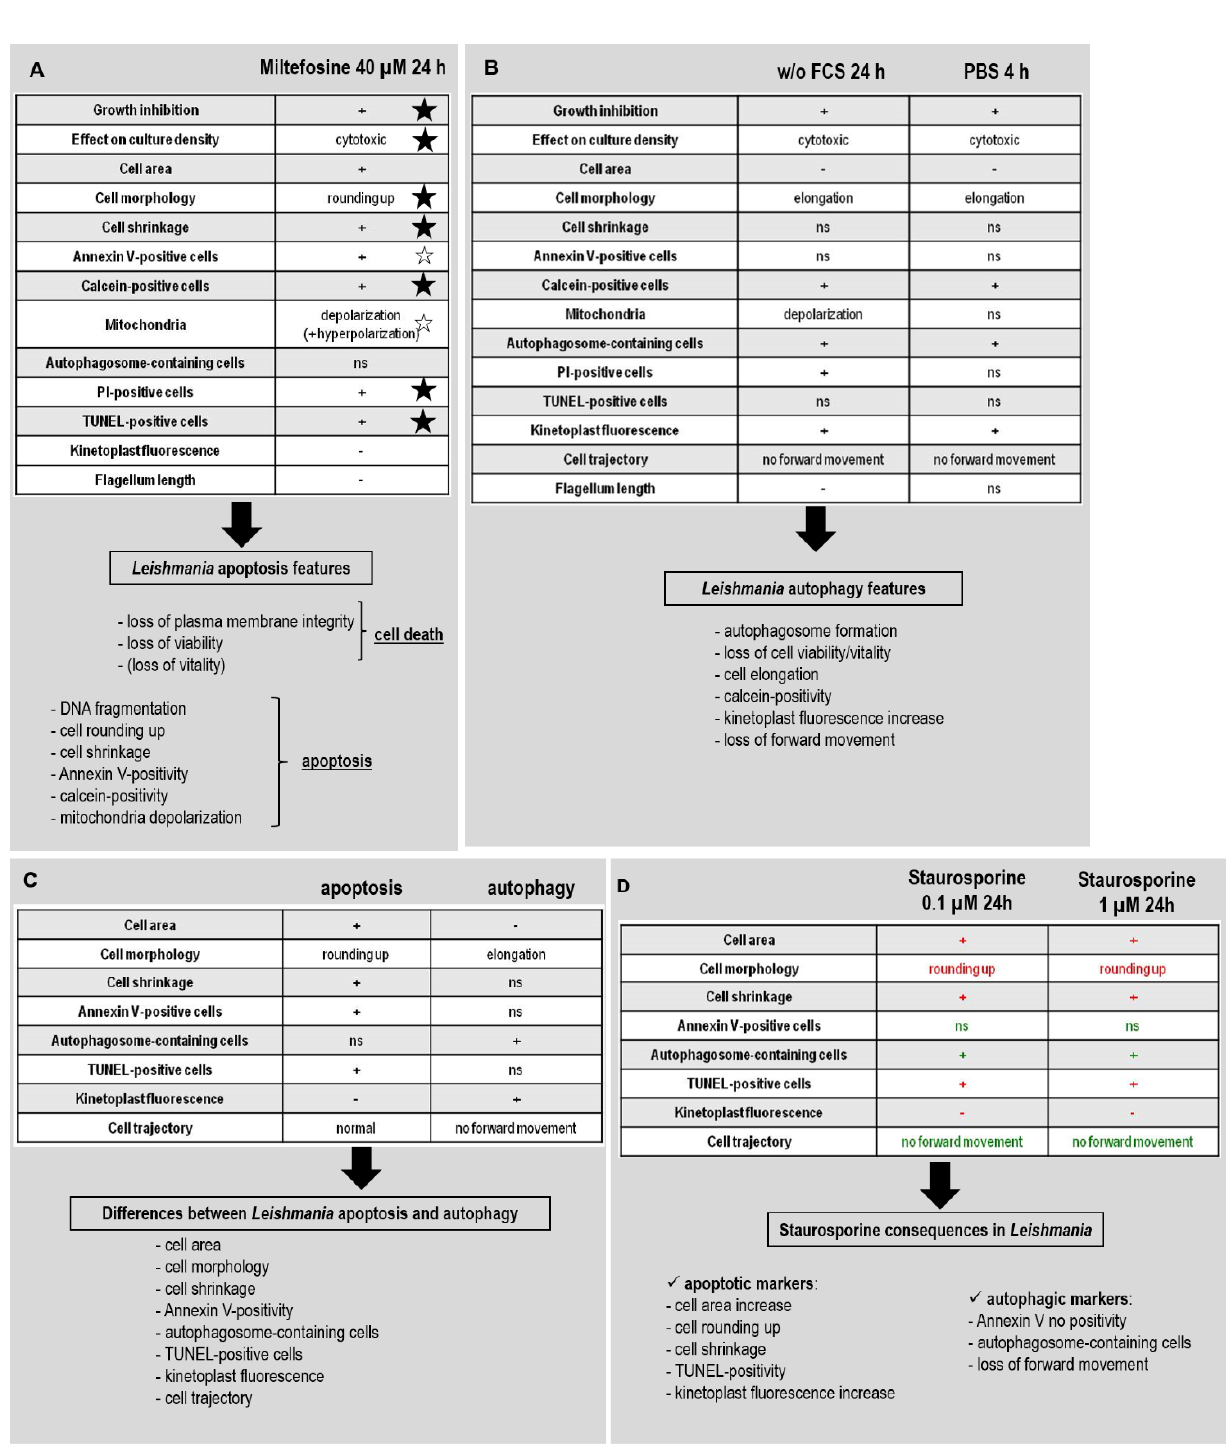
FIGURE 7: Proposed procedure to identify Leishmania apoptotic cells, autophagic cells and to clearly distinguish apoptosis and autophagy. (A) Leishmania miltefosine-induced apoptosis markers. A star indicates the apoptotic markers that have been found not only in miltefosine- induced apoptosis but also after induction of apoptosis by other molecules: a solid star when demonstrated in this article and an empty star when shown in the literature (see discussion for details). The proposed approach to demonstrate Leishmania apoptosis is also summarized. (B) Leishmania autophagy markers. The list of features observed in deprivation conditions (without FCS for 24 h and in PBS for 4 h) as well as the proposed approach to demonstrate Leishmania autophagy are summarized. (C) Features to distinguish apoptosis and autophagy in Leish- mania . The characteristics that are different during Leishmania apoptosis and autophagy and so that allow distinguishing the two processes are enumerated. (D) Features induced by staurosporine in Leishmania . Staurosporine induces apoptotic (in red) as well as autophagic (in green) features in Leishmania